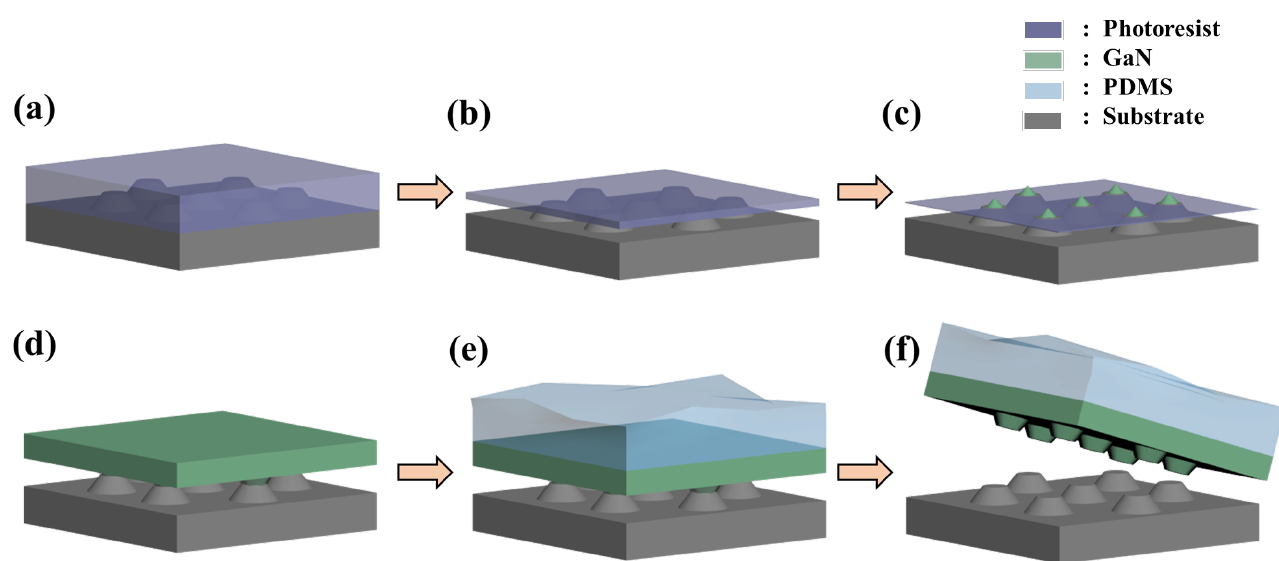
Figure 1. Schematic of the process for fabricating GaN epitaxial lateral overgrowth with air tunnel; ( a ) spin coating of photoresist, ( b ) carbonization of photoresist, ( c ) GaN selective area growth, ( d ) GaN epitaxial lateral overgrowth, ( e ) PDMS coating to enable handling, and ( f ) CLO with KOH solution.